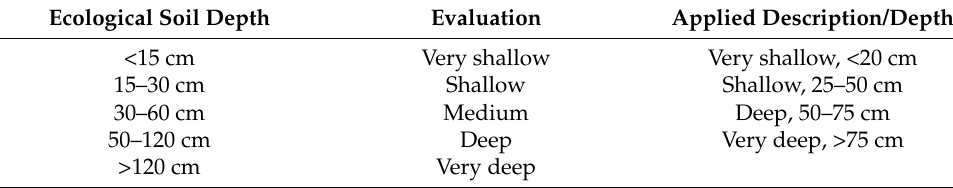
Table 2. Comparison of ecological and applied soil depth in this work. Source: [31]. Ecological Soil